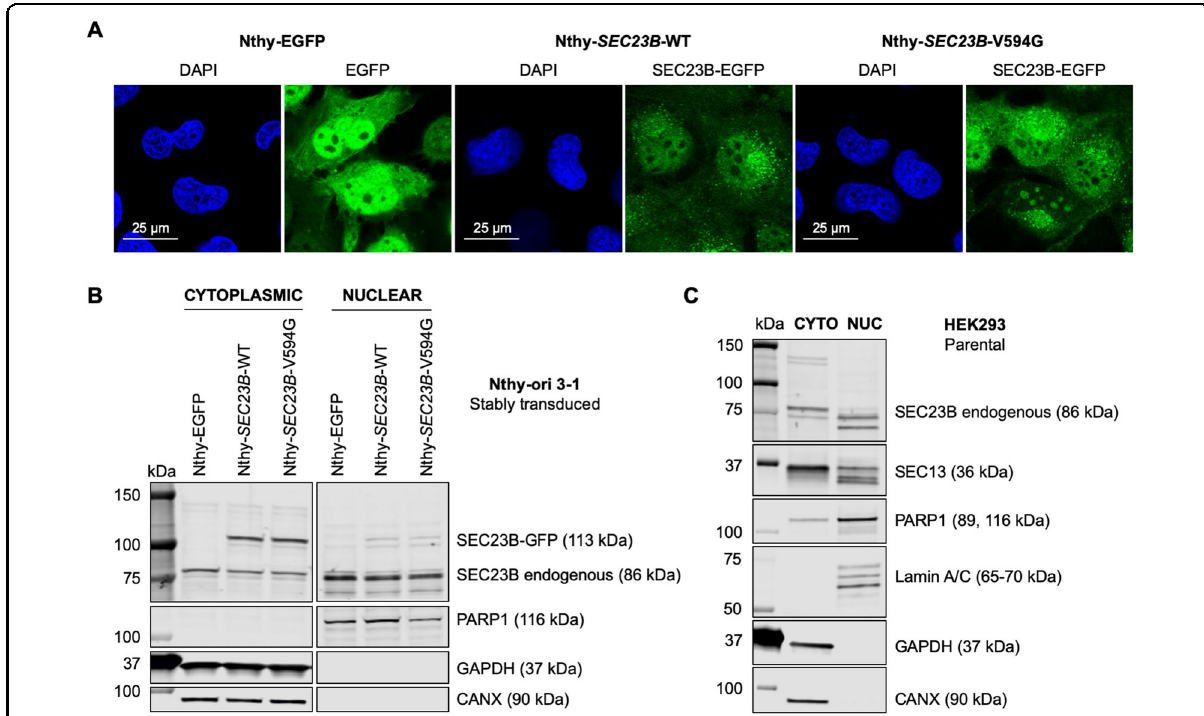
Fig. 1 Wild-type SEC23B localizes to the nucleus. A Non-malignant thyroid Nthy-ori 3-1 cells were stably transduced with EGFP, wild-type SEC23B , and mutant p.Val594Gly SEC23B (the latter two fused with EGFP). Nthy- SEC23B -WT and Nthy- SEC23B- V594G cells show nuclear expression of SEC23B. Nthy-EGFP cell line is used as a control to show non-speci fi c GFP subcellular localization. Blue, DAPI; green, SEC23B-EGFP or EGFP. Scale bars, 25 μ m. B Protein levels after nuclear – cytoplasmic fractionation in stably transduced Nthy-ori 3-1 cells detects endogenous and EGFP-tagged SEC23B in the nuclear compartment. Nthy-EGFP cell line is used as a control to indicate baseline endogenous levels of SEC23B. PARP1, nuclear marker; GAPDH, cytoplasmic marker; CANX, endoplasmic reticulum marker. C Protein levels after nuclear – cytoplasmic fractionation in parental HEK293 cells detects endogenous SEC23B in the nuclear compartment. PARP1 and Lamin A/C, nuclear markers; GAPDH, cytoplasmic marker; CANX, endoplasmic reticulum